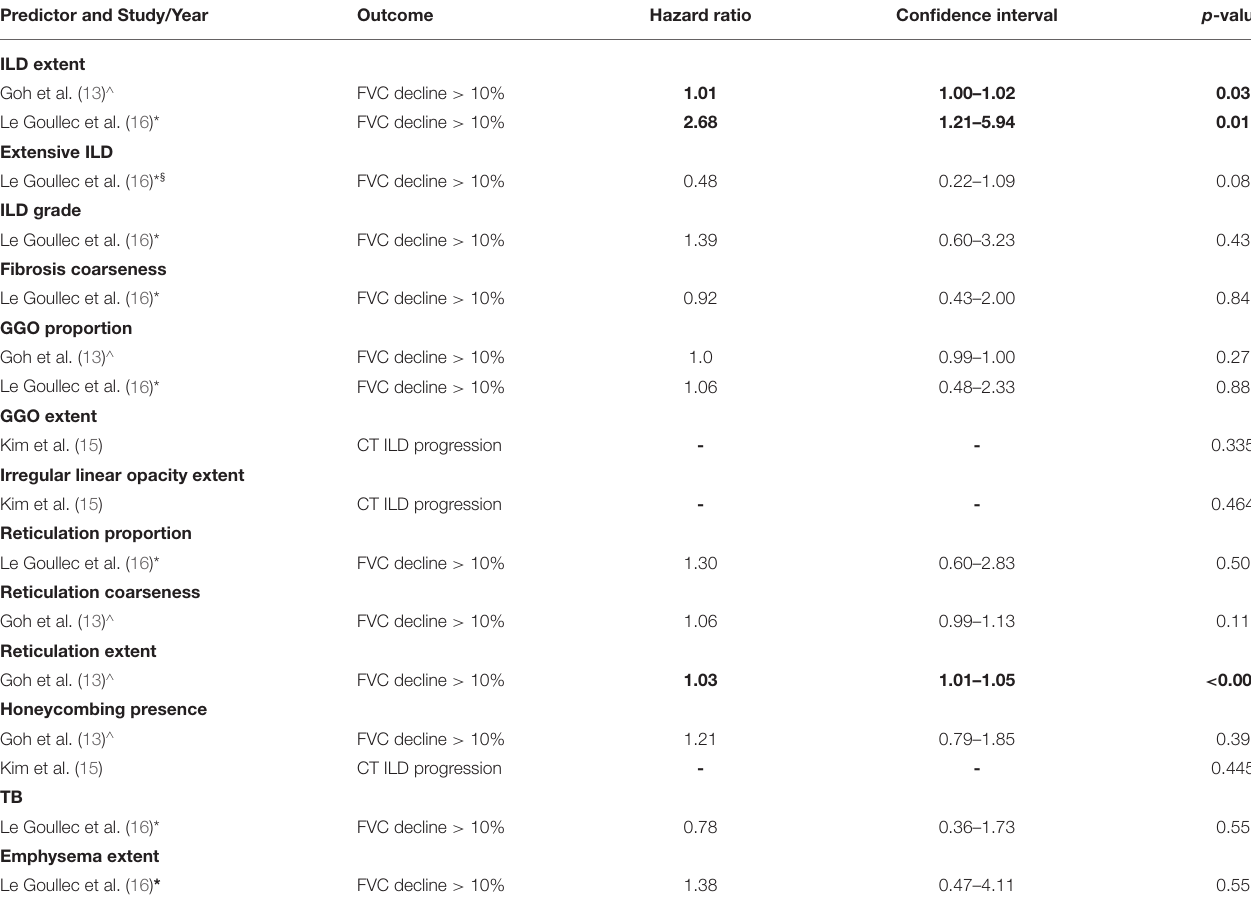
TABLE 4 | Predictors of ILD progression, univariate analysis. Predictor and Study/Year Outcome Hazard ratio Confidence